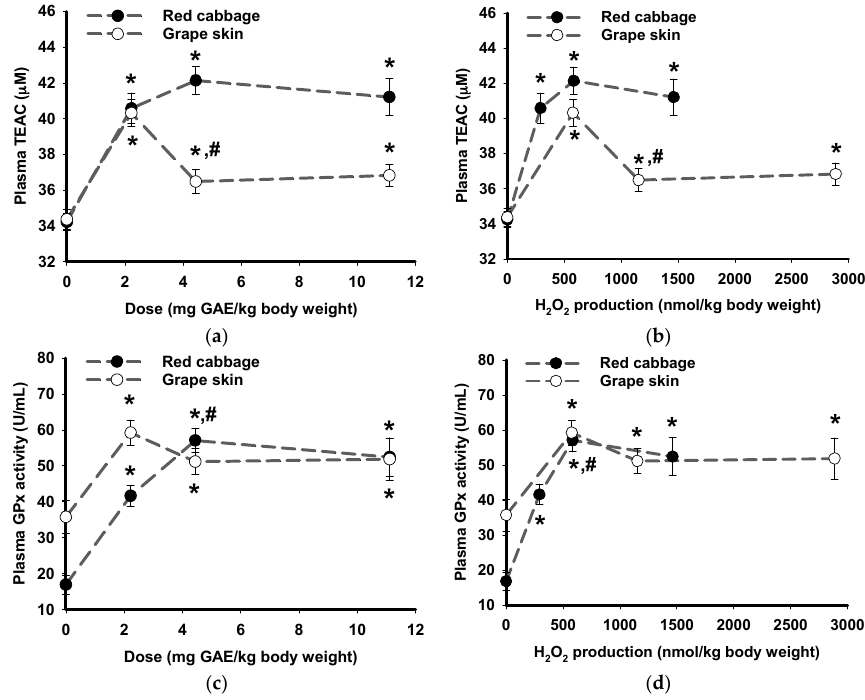
Figure 4. Total plasma antioxidant capacity and glutathione peroxidase activity of pig plasma as a function of phytochemical dose and H 2 O 2 production efficacy. Means across all pig plasma sampling time points (0.5 h interval for 4 h) of plasma TEAC versus ( a ) phytochemical doses and ( b ) H 2 O 2 production efficacy. Means across all pig plasma sampling time points of plasma GPx activity versus ( c ) phytochemical doses and ( d ) H 2 O 2 production efficacy. The H 2 O 2 production (nmol/kg body weight) was calculated based on the yield of H 2 O 2 production (nmol/ µ mol GAE) of the plant